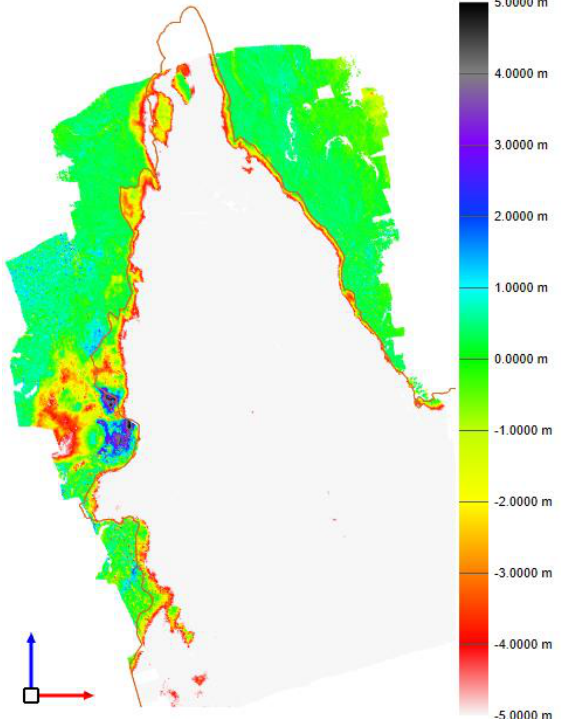
Figure 7. Height comparison map between 2014 DPC co- registered using CONFBLOCKS method and 2016 DPC: focus on the area outside the